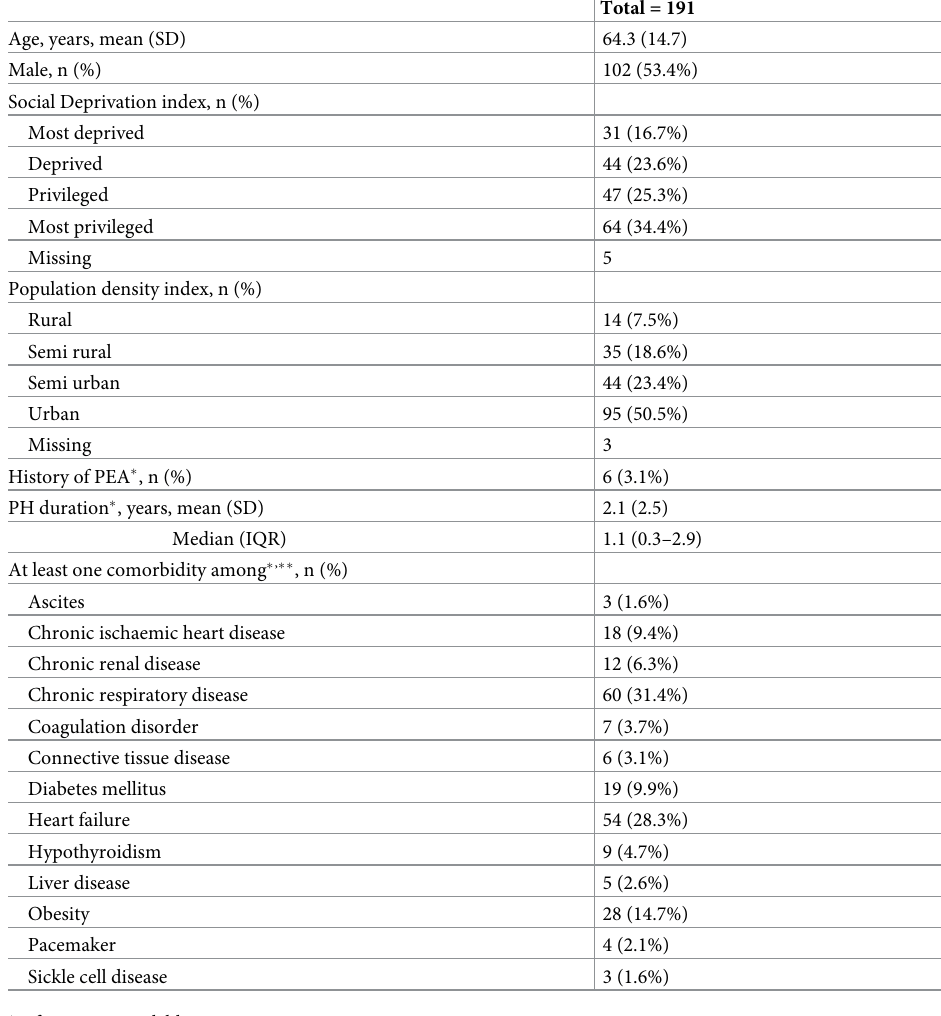
Table 1. Demographic and medical characteristics of patients at